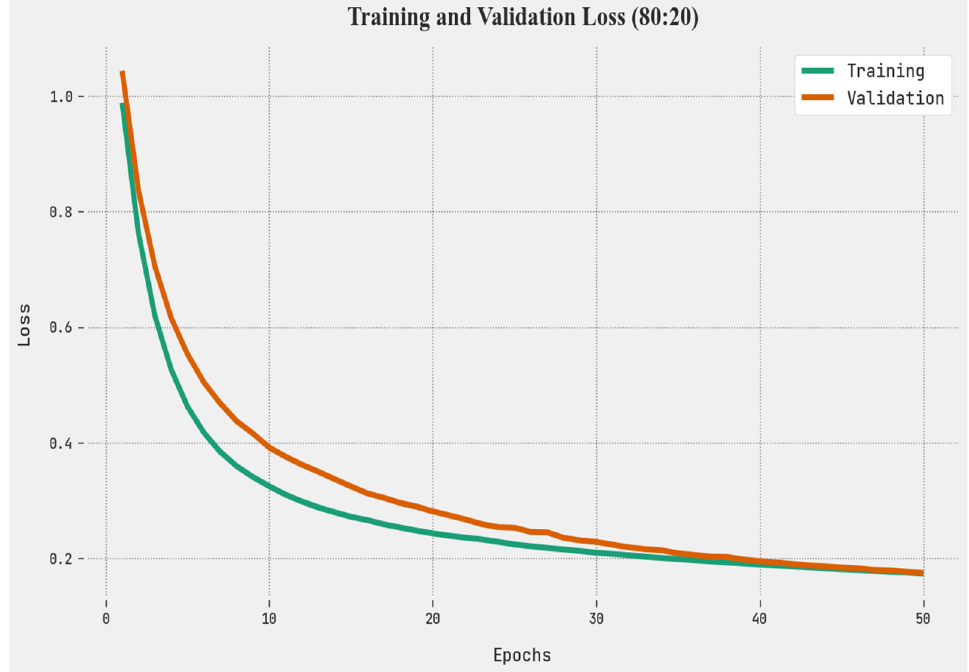
Figure 7. TLS and VLS analysis of TSADL-LULCCD approach on 80:20 of TR/TS databases.